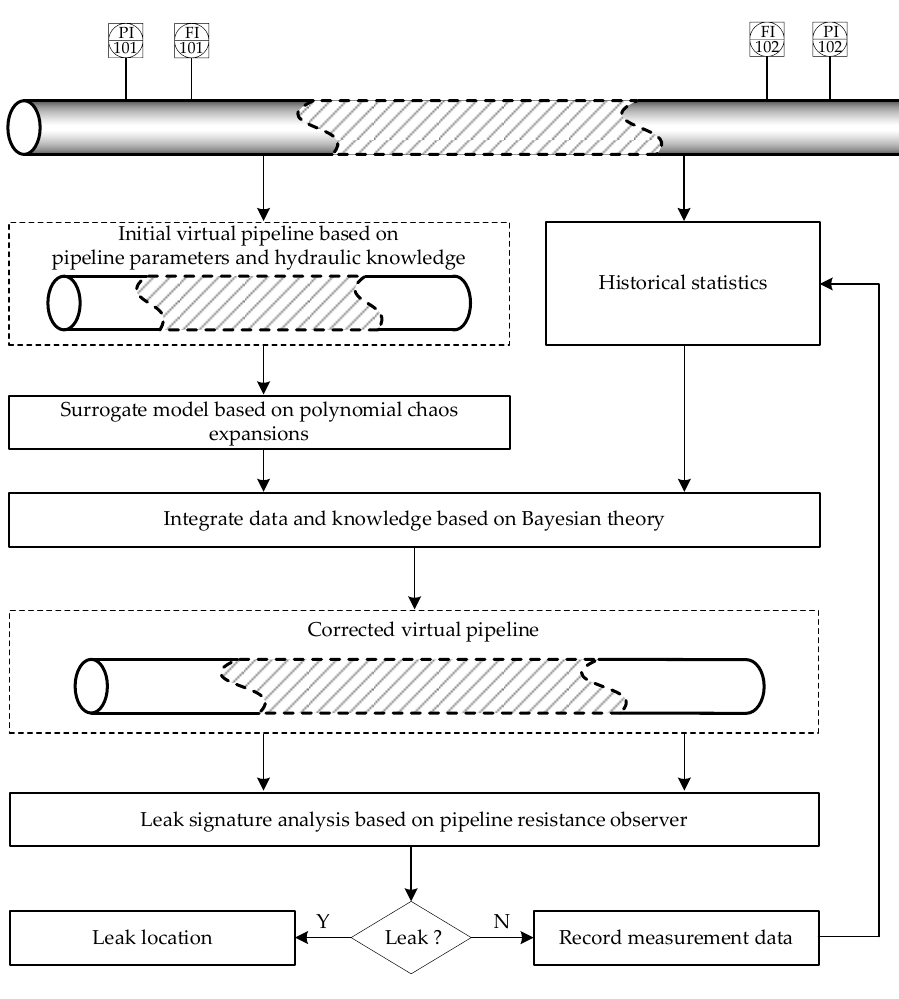
Figure 1. The framework of the proposed method.